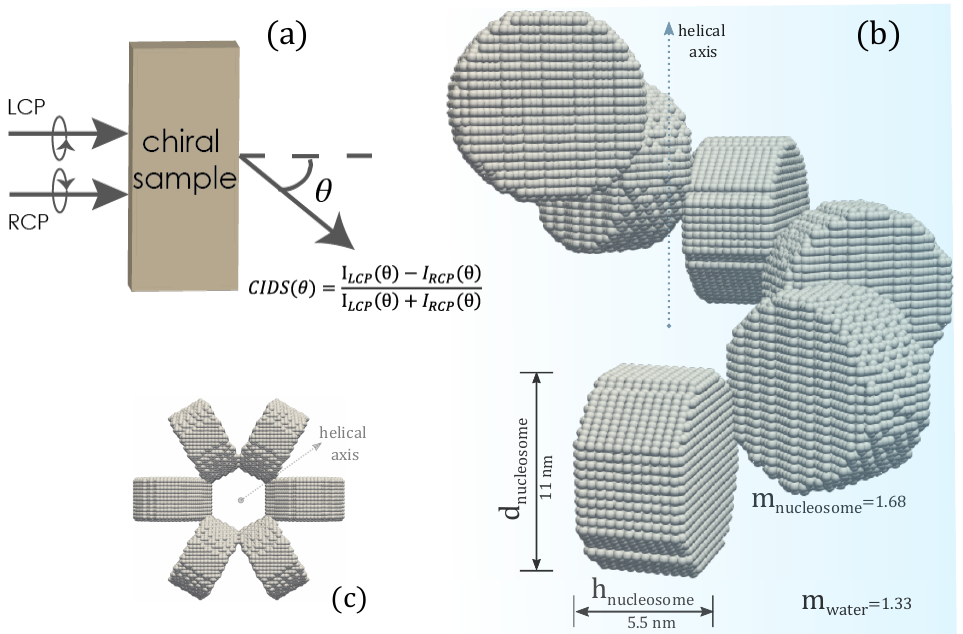
Figure 1. ( a ) Representation of CIDS, ( b ) the discrete dipole model of chromatin fiber, ( c ) projected view along the helical axis.